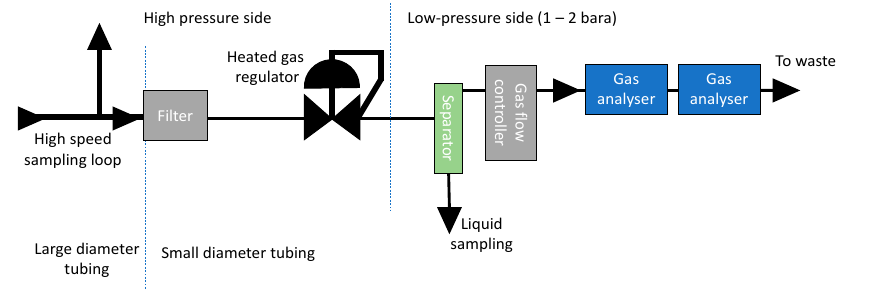
Figure 5. Schematic flowchart for analysis system.